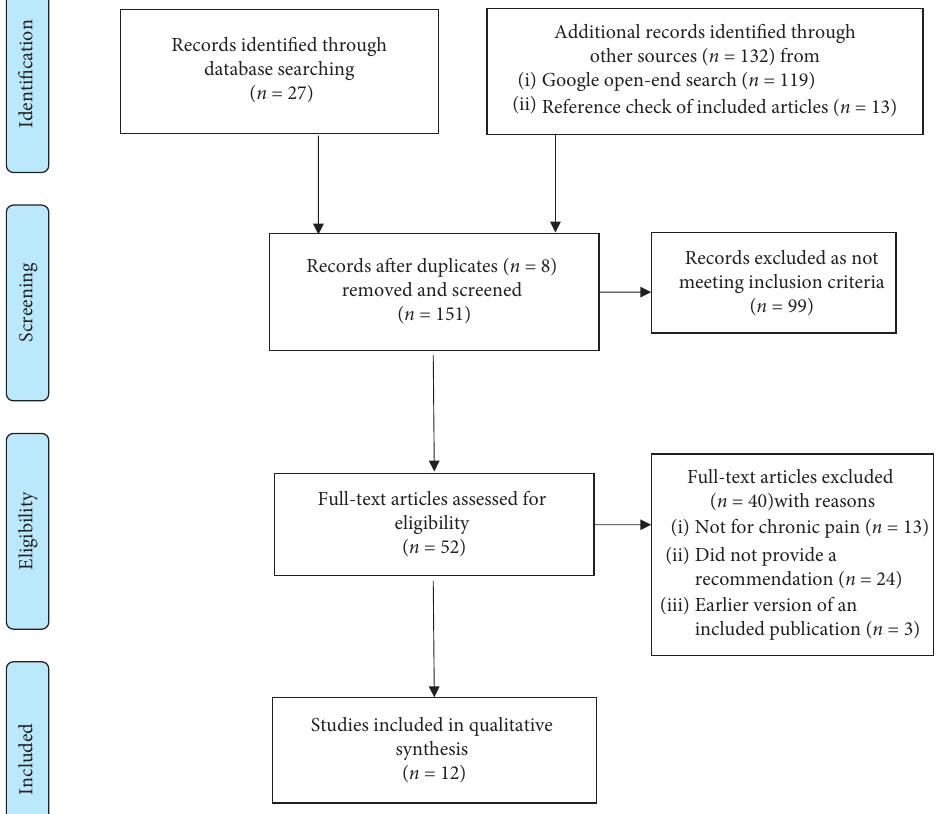
Figure 1: Eligibility assessment PRISMA flow